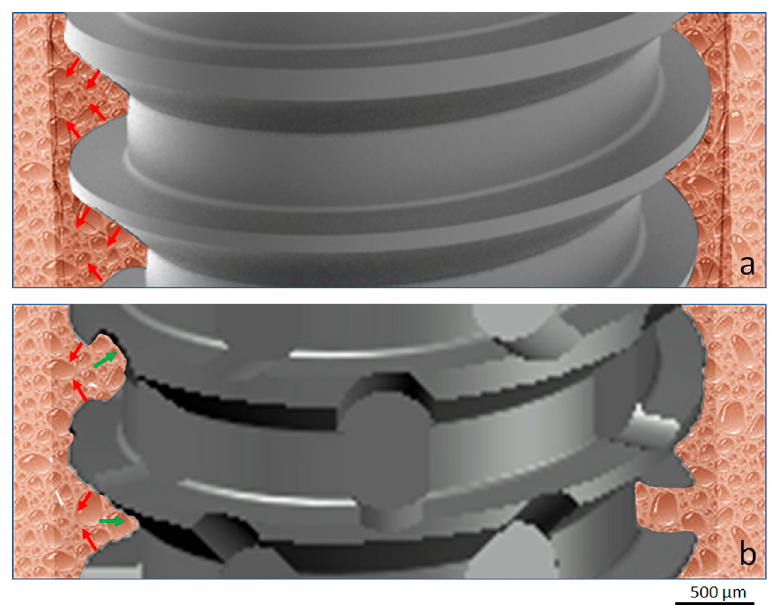
Figure 14. Schematic image to show the bone compression during the implant installation (red arrows) and decompression (green arrows) on the healing chambers. ( a ) Conventional threads design and ( b ) new threads design with healing chambers.